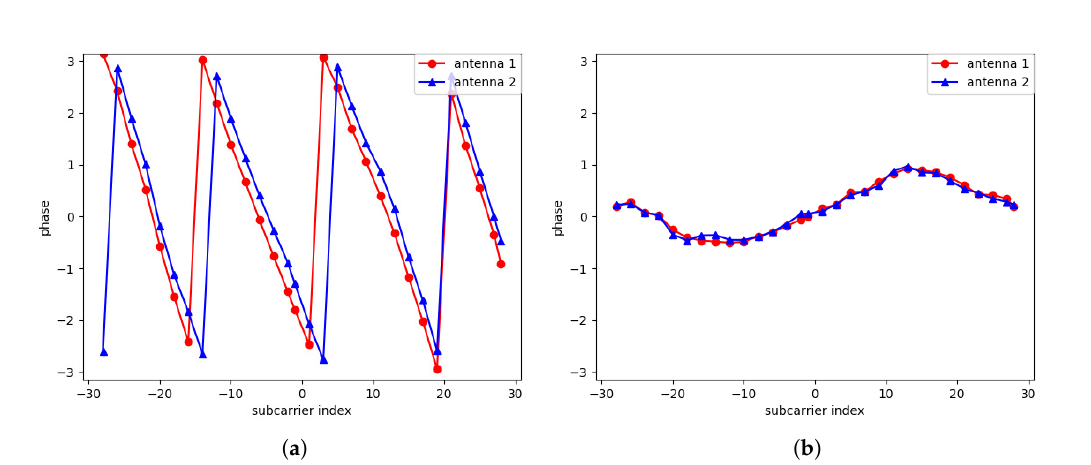
Figure 2. The result of phase calibration: ( a ) raw phase measurement, and ( b ) calibrated phase.